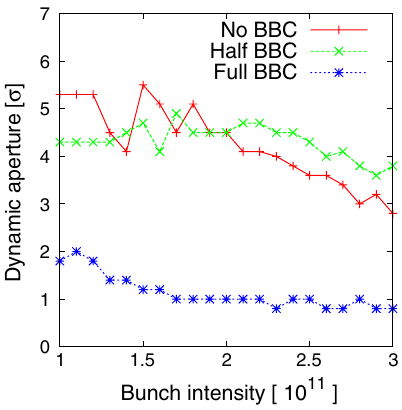
FIG. 8. Dynamic apertures of four proton bunch intensities versus head-on beam-beam compensation strength. For half and full beam-beam compensation, the compensation strengths are 0.5 and 1.0,